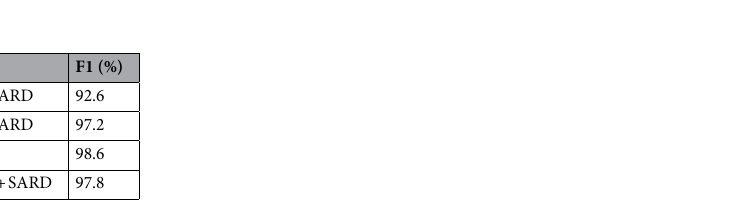
Table 5. The experimental results of binary classification between related work tools and